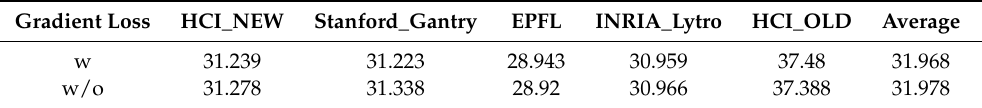
Table 3. Ablation study of Gradient Loss in the proposed model. We compare the performance of the model with (w) or without (w/o) Gradient Loss on different test datasets and report the PSNR results. Gradient